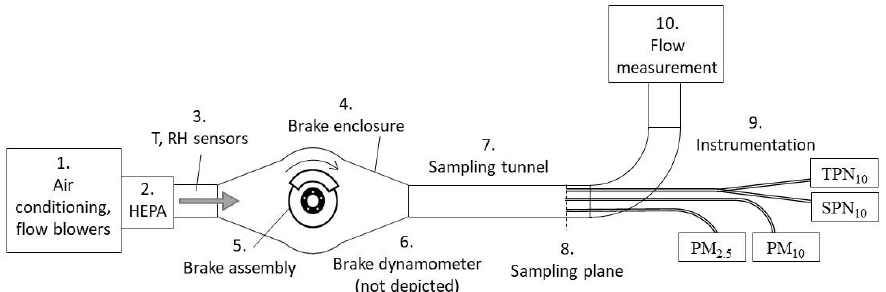
Figure 1. Example of a laboratory setup for the measurement of brake emissions. HEPA = high efficiency particulate air filter; PM = particulate matter; RH = relative humidity; SPN = solid particle number; T = temperature; TPN = total particle number.